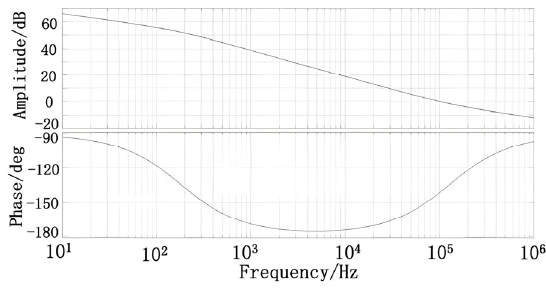
Figure 7. Bode diagrams of the proposed compensator.